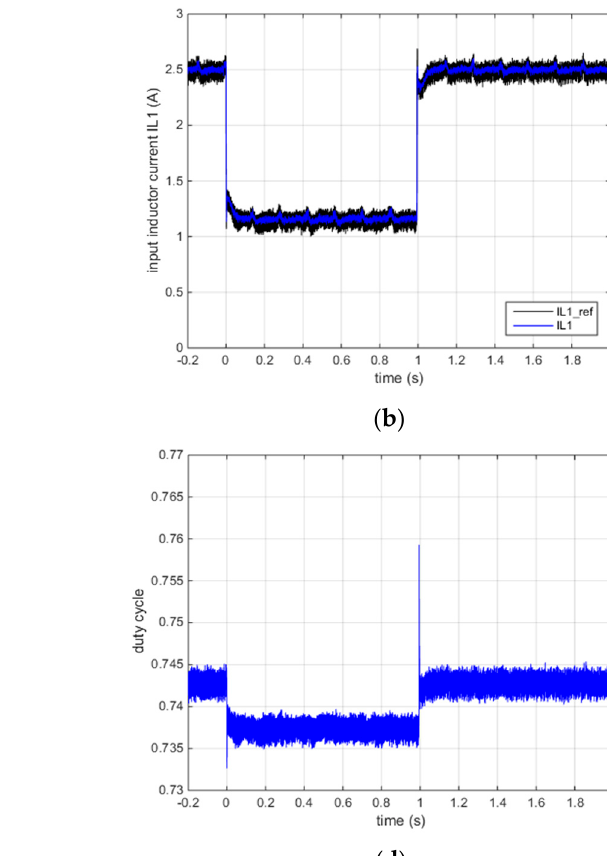
( b ) Figure 11. Experimental results in scenario #2 (SD − GN): ( a ) grid − side currents; ( b ) percentage variation of microgrid voltage. It is worth noting that the external power supply did not offer a proper current-mode operation; actually, it tried to impose the preset voltage (185 V) and continuously adjusted its output voltage aiming to respect the current limit. This behavior explains the initial peak in the generator’s current. Nevertheless, the converter’s control system was fast enough to effectively compensate for the connection and disconnection of the external generator. Therefore, the over/undershoot of microgrid voltage was minimal (+1.1% and − 0.5%). 5.3. Experimental Validation in Scenario #3 (SD-GD) In this test, the Split-pi converter and the microgrid voltage generator were con- trolled in droop mode with R d ≠ 0, so the resulting microgrid was not stiff. For the sake of clarity, a droop resistance of 1.33 Ω and a no-load voltage of 180 V were chosen as droop